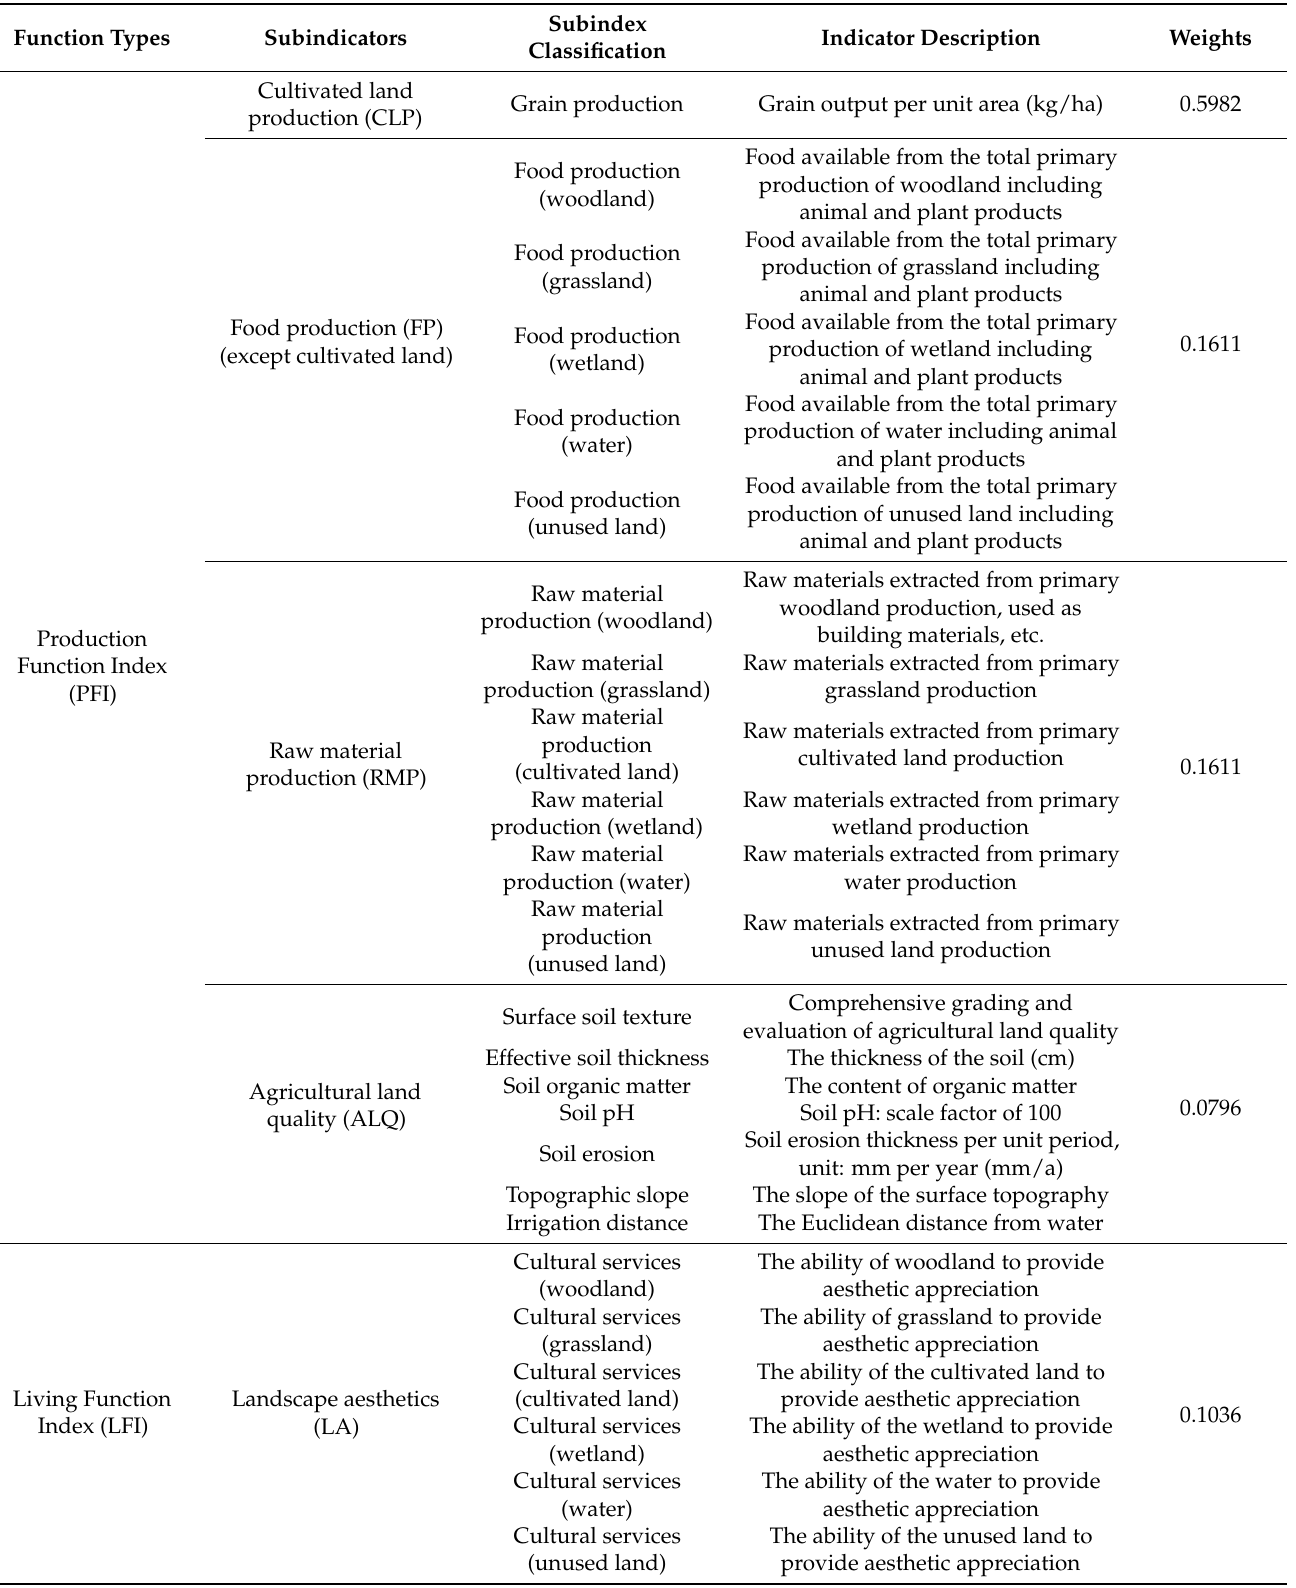
Table 3. Function types, subindicators, subindex classification, indicator description, and weights of the PLE